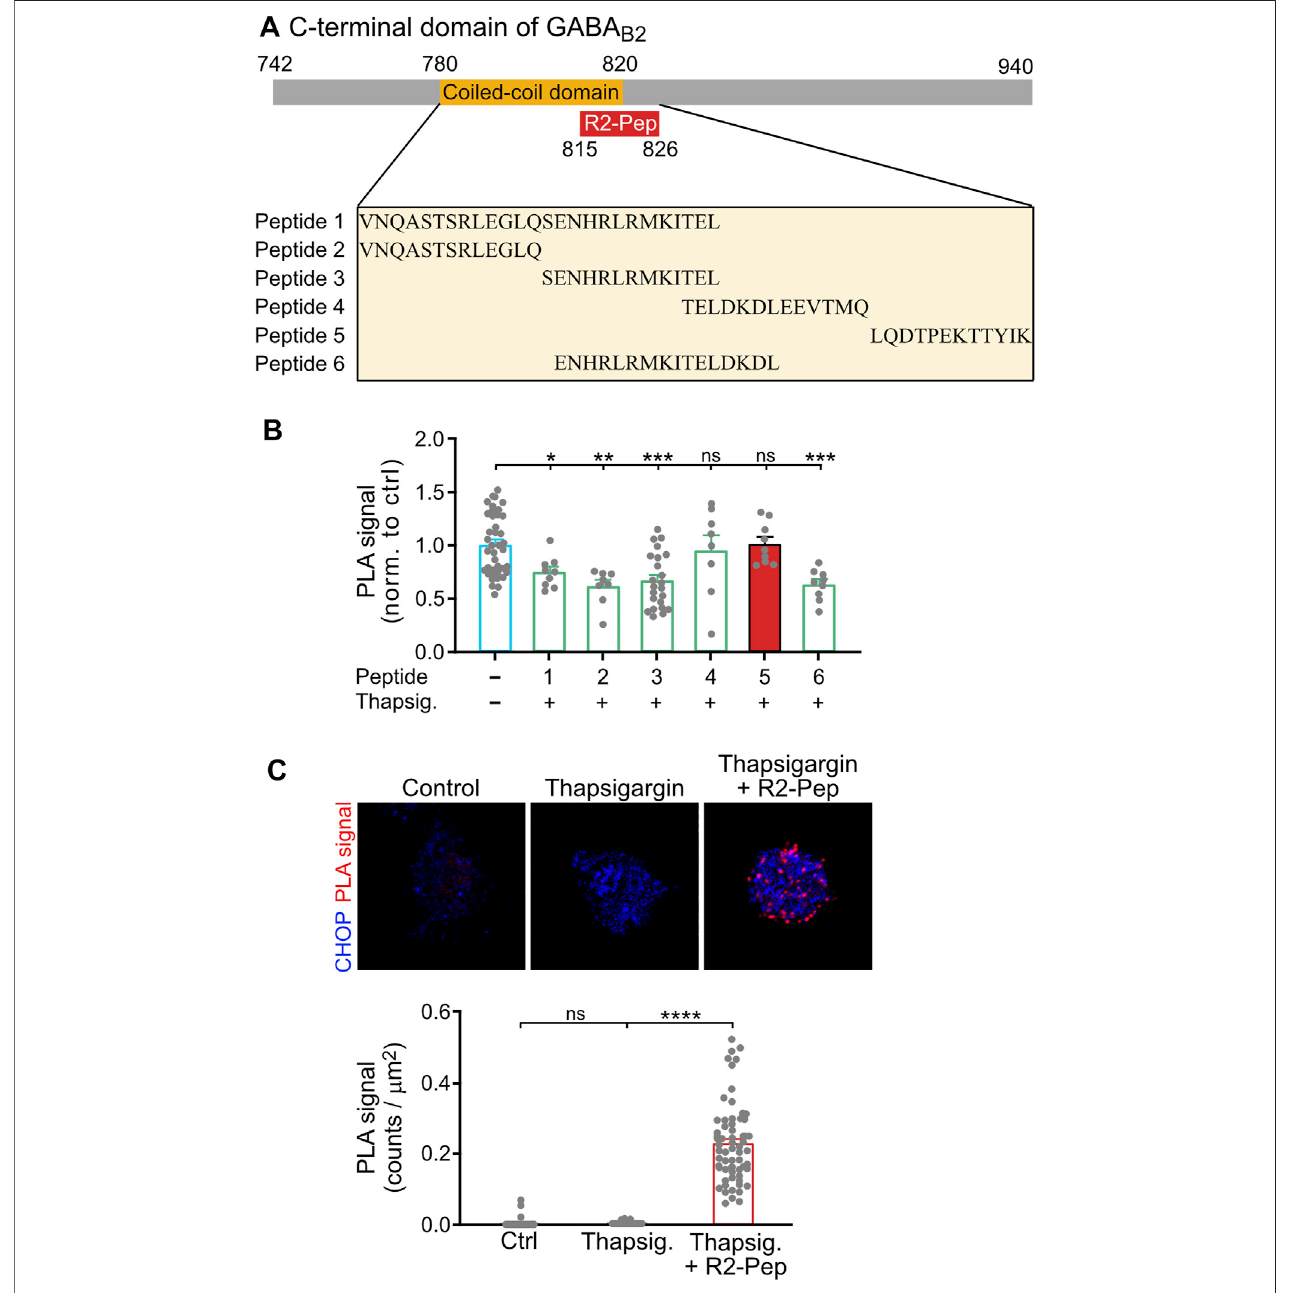
FIGURE2| Screeningforapeptide(R2-Pep)interferingwiththeinteractionofCHOPwithGABA B receptors. (A) SchemeoftheC-terminaldomainofGABA B2 with the coiled-coil domain (orange box), which contributes to the CHOP-GABA B receptor interaction site and location of the interfering peptide R2-Pep sequence (red box). The box below depicts the GABA B2 peptide sequences used for screening. (B) Peptide 5 reliably prevented stress-induced decrease in GABA B1 /GABA B2 heteromers. Cultures were stressed for 2 h with thapsigargin (1 μ M) and immediately thereafter treated for 30 min with the peptides indicated in (A) . Neurons were then tested fortheinteractionbetweenGABA B1 andGABA B2 by insitu PLA.The insitu PLAsignalsoftheuntreatedneuronsservedascontrol(-,nopeptide).Thedatarepresentthe mean ± S.E.M. of 8 – 40 neurons derived from two independent experiments (control, n = 4). ns, p > 0.05; *, p < 0.05; **, p < 0.005; ***; p < 0.0005. Brown-Forsythe/ Welch one-way ANOVA followed by Games-Howell ’ s multiple comparison test. (C) R2-Pep (peptide 5 in B ) interacted with CHOP. Cultures were stressed for 2 h with thapsigargin (1 μ M) and immediately thereafter treated with R2-Pep for 30 min. Neurons were then tested for the interaction of CHOP with R2-Pep by in situ PLA using antibodiesdirectedagainstCHOPandFITC(R2-PepwaslabeledwithFITCattheN-terminus).Thedatarepresentthemean±S.E.M.of47 – 62neuronsderivedfromtwo independent experiments. ns, p > 0.05; ****; p < 0.0001. Kruskal – Wallis test followed by Dunn ’ s multiple comparison test.